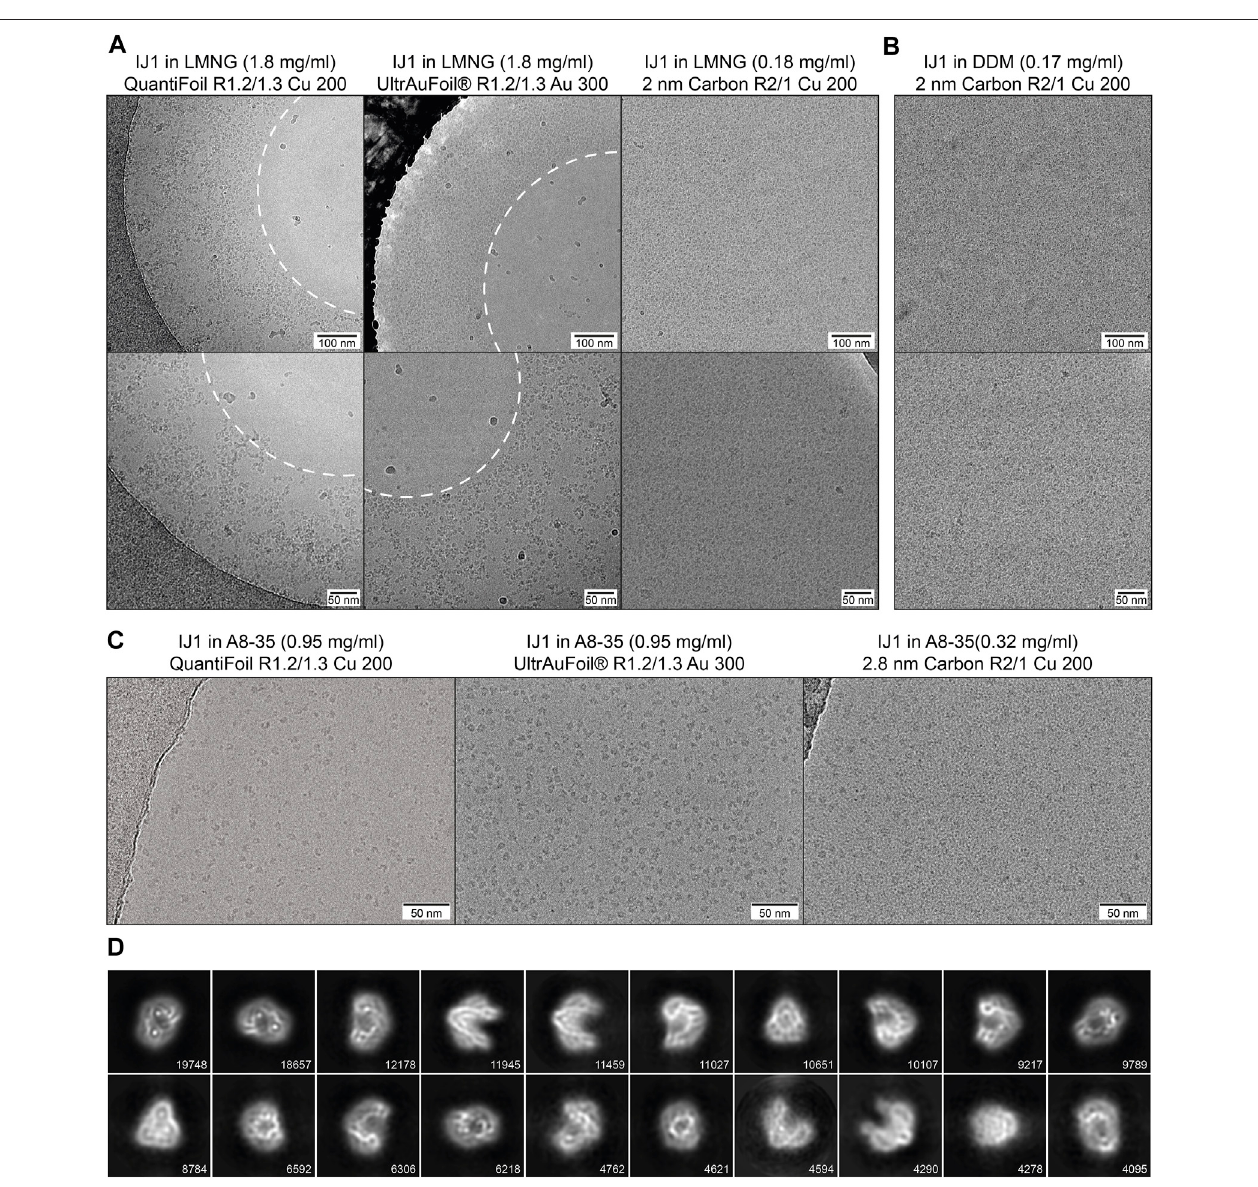
FIGURE 6 | (A) In fl uence of different grid types on the particle distribution of IJ1 in LMNG. The protein localizes to regions of thick ice on copper QuantiFoil and UltrAuFoil grids and is omitted from regions ofthin ice inthe middle ofthe holes(markedbythe white dashed line). A 2 nm layer ofcarbon leadsto aneven distributionof particles throughout the grid holes. (B) A similar distribution is seen for IJ1 in DDM on 2 nm carbon-coated grids. Shown are example images in two magni fi cations (1.58 Å/px upper row, 1.23 Å/px lower row). (C) IJ1 in A8-35 on QuantiFoil, UltrAuFoil, and 2.8 nm carbon-coated grids (0.68 Å/px). IJ1 reconstituted in A8-35 is more evenly distributed compared to LMNG solubilized particles. (D) 2D class averages for A8-35 reconstituted Ij1 on the QuantiFoil R1.2/1.3 grid. Shown are the 20 most populated classes of 80. The number of particles is shown for each